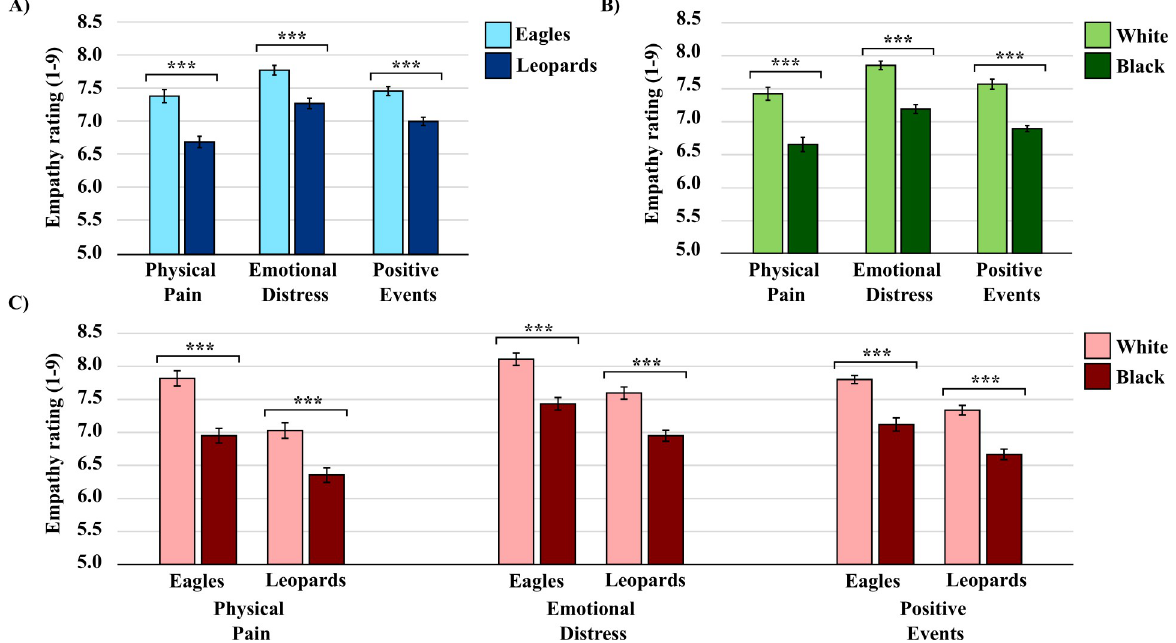
Fig 3. Self-reported empathy ratings in response to physically painful, emotionally distressing, and positive events. Empathy ratings for (A) ingroup (Eagles) versus outgroup (Leopards) teams, for (B) White versus Black African team members, and for (C) Team x Race interactions. Empathy ratings in response to physically painful and emotionally distressing events were determined by how “sorry” the events made participants feel, whereas empathy ratings in response to positive events were determined by how “good” the events made participants feel. Error bars indicate standard error of the mean. *** p <